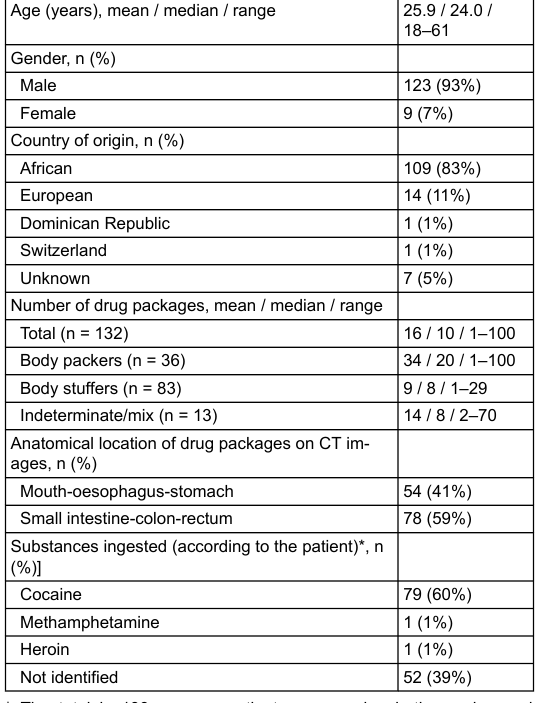
Table 1: Sociodemographic characteristics of patients (n = 132) and characteristics of the ingested substances. Age (years), mean / median / range